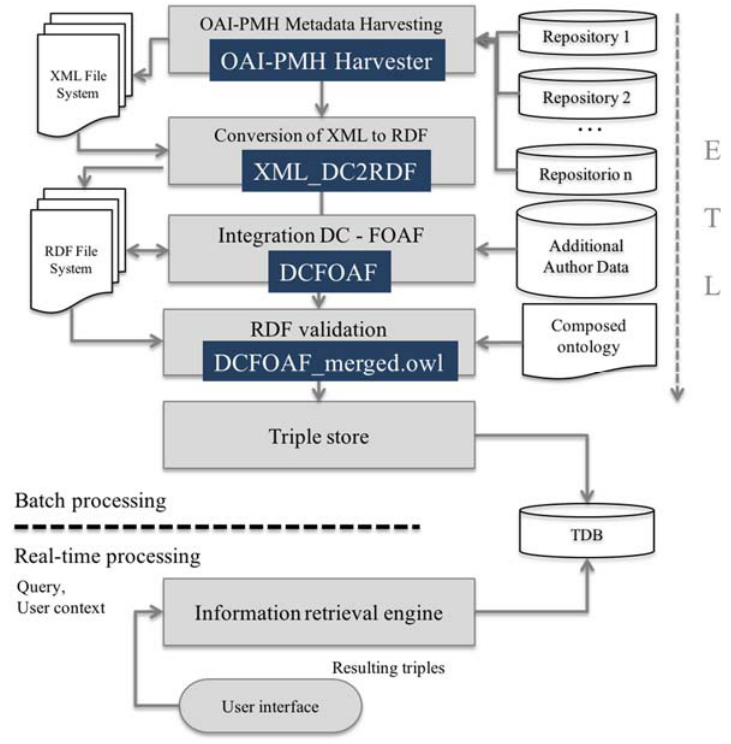
Figure 1. OntoOAI Methodology.